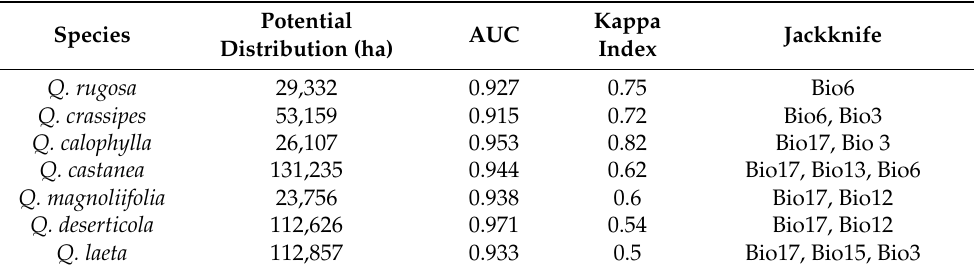
Table 2. Potential distribution area (ha) for the models with the highest Kappa index and Area Under the Curve (AUC) and the most influential bioclimatic variables to the distribution explored through a Jackknife test of the seven most abundant oak species in the Cuitzeo Lake Basin, Mi- choac á n, Mexico. Acronyms: Bio3: isothermality; Bio6: minimum temperature of the coldest